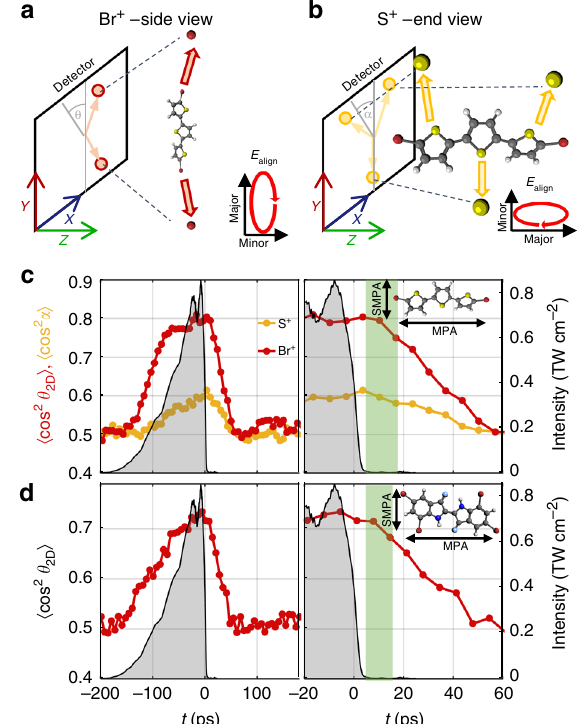
Fig. 2 3D alignment of dibromoterthiophene and tetrabromoindigo. a , b Illustration of how 3D alignment of DBT is characterized. In a the molecule is in a side view with the most polarizable axis (MPA) con fi ned to the major polarization axis of the alignment pulse, directed along the Y -axis. In b the molecule is in an end view, with the MPA and major polarization axis directed on the Z -axis. In the side view, alignment is characterized by cos 2 θ 2 D h i , where θ 2D is the angle between the emission direction of a Br +